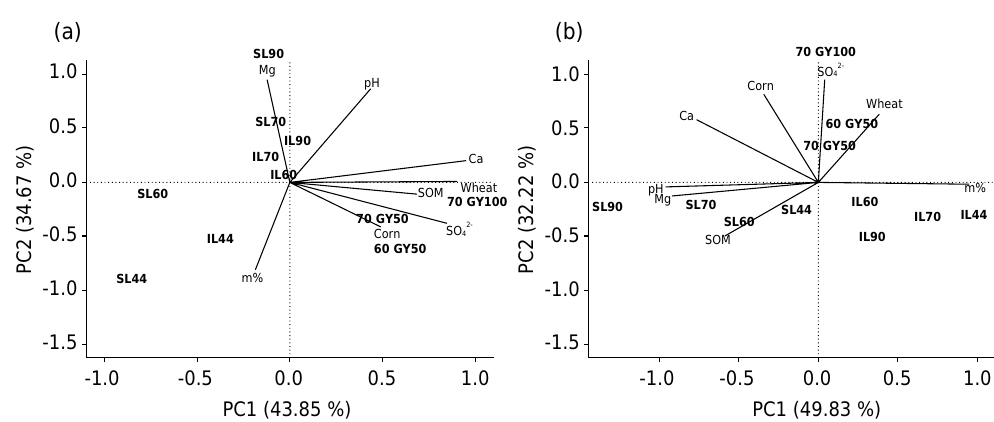
Figure 8. Biplot between PC1 and PC2 (n = 11) between wheat and corn yields and soil properties in the 0.00-0.20 m layer (a) and 0.20-0.60 m layer (b), which explain 78.52 and 82.05 % of the variance, respectively. In bold are the treatments, in which SL represents surface liming; IL represents incorporated liming; 44, 60, 70, and 90 represent base saturation (%); GY50 represents the recommended phosphogypsum rate (3.71 Mg ha -1 ); and GY100 represents twice the recommended phosphogypsum rate (7.42 Mg ha -1 ).